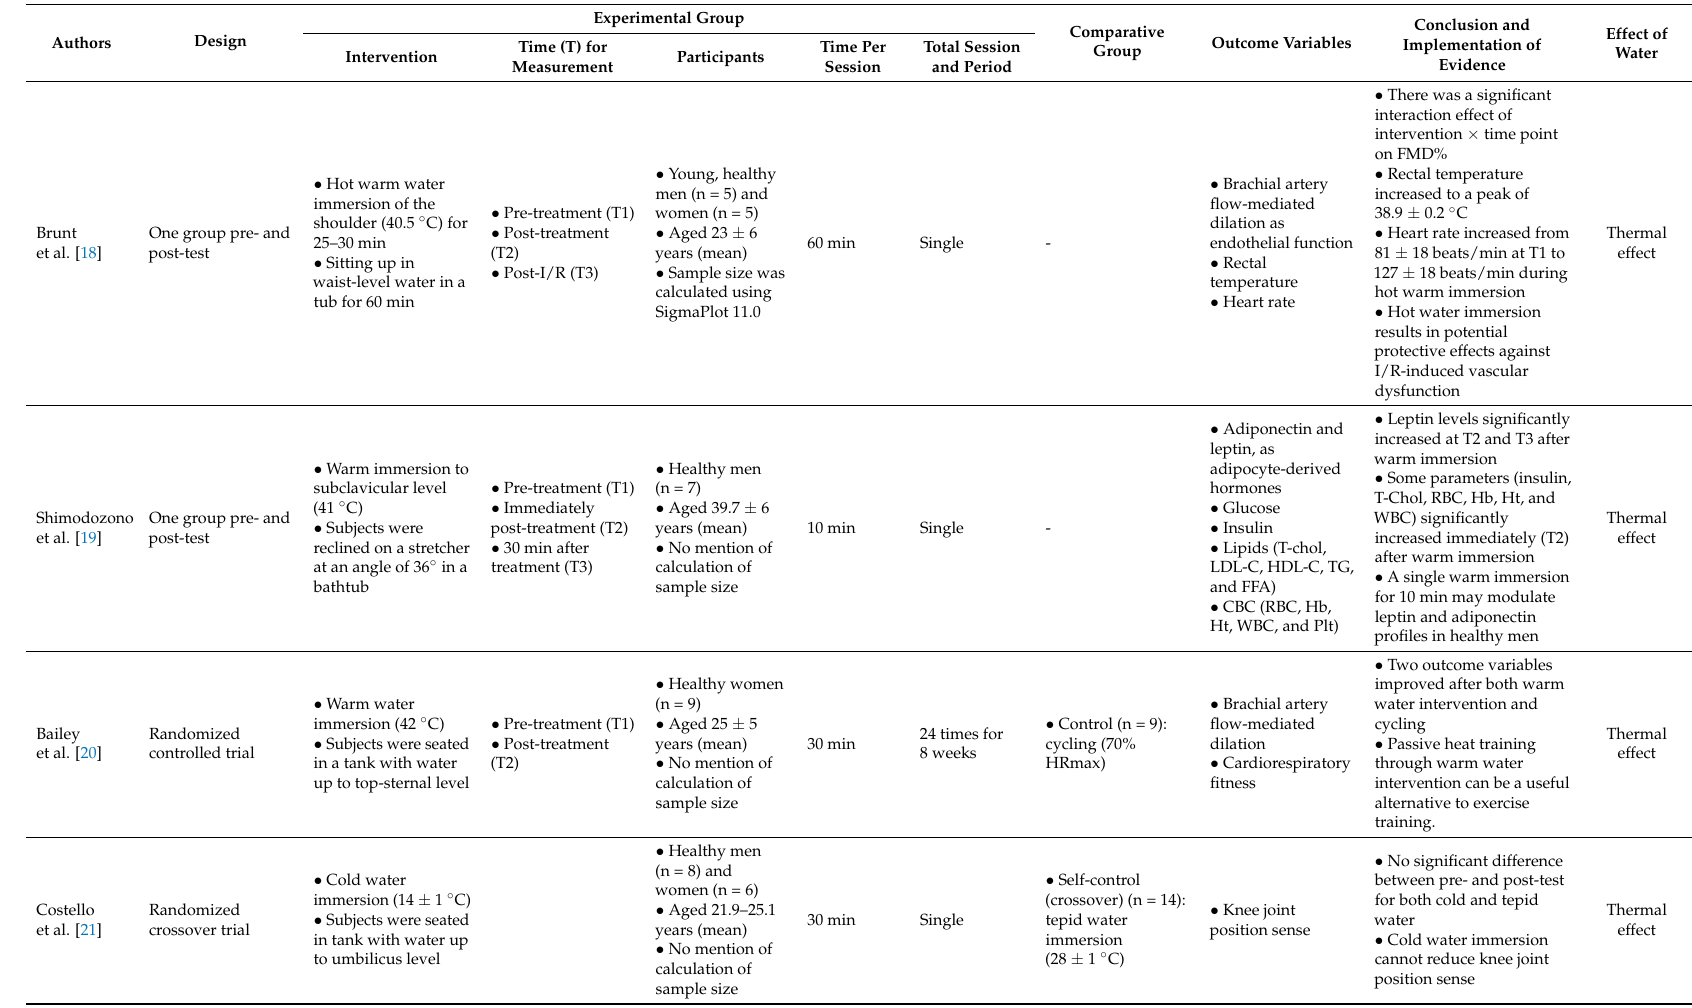
Table 2. Result of review of the included